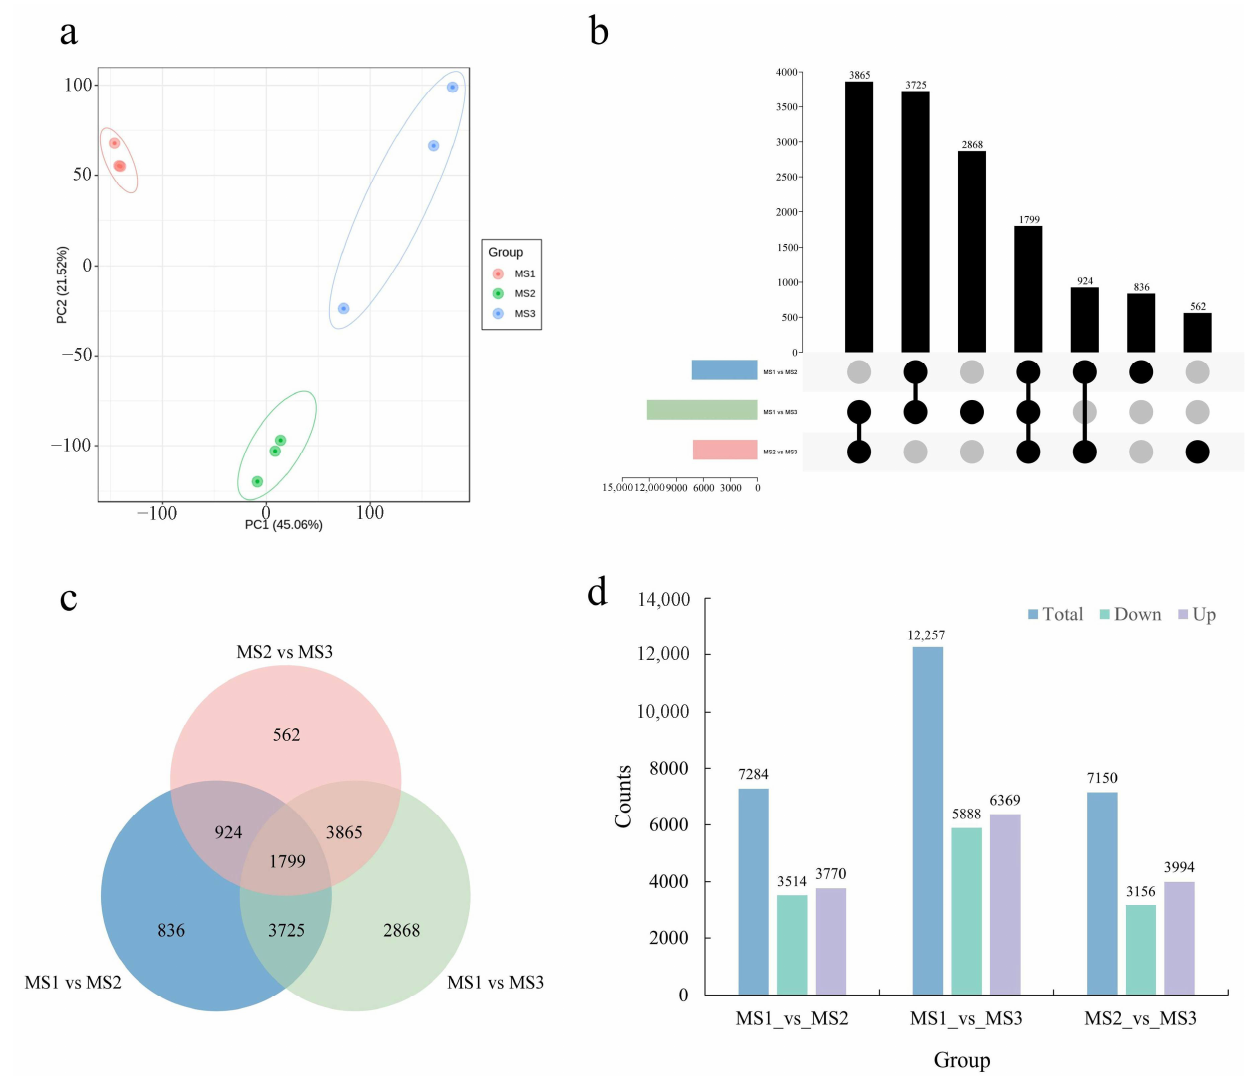
Figure 3. Identification and functional enrichment of differentially expressed genes at the male flowering transition process. ( a ) PCA score plot of expression profiles from different samples; ( b ) Upset diagram of DEGs in different comparison groups; ( c ) Venn diagram of DEGs in different comparison groups; ( d ) the statistical analysis of up-regulated and down-regulated DEGs among different comparison groups.